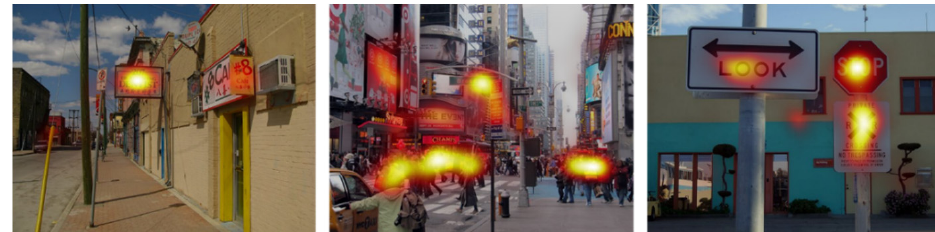
Figure 6. Image examples from the SALICON dataset [53], which includes urban and rural landscape images that contain wayfinding signs.